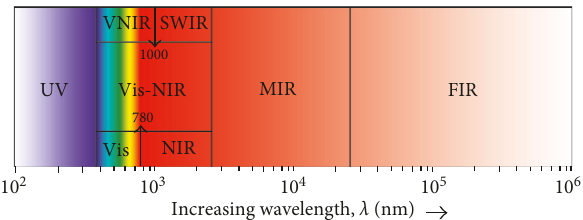
Figure 1: Optical spectrum between 10 2 to 10 6